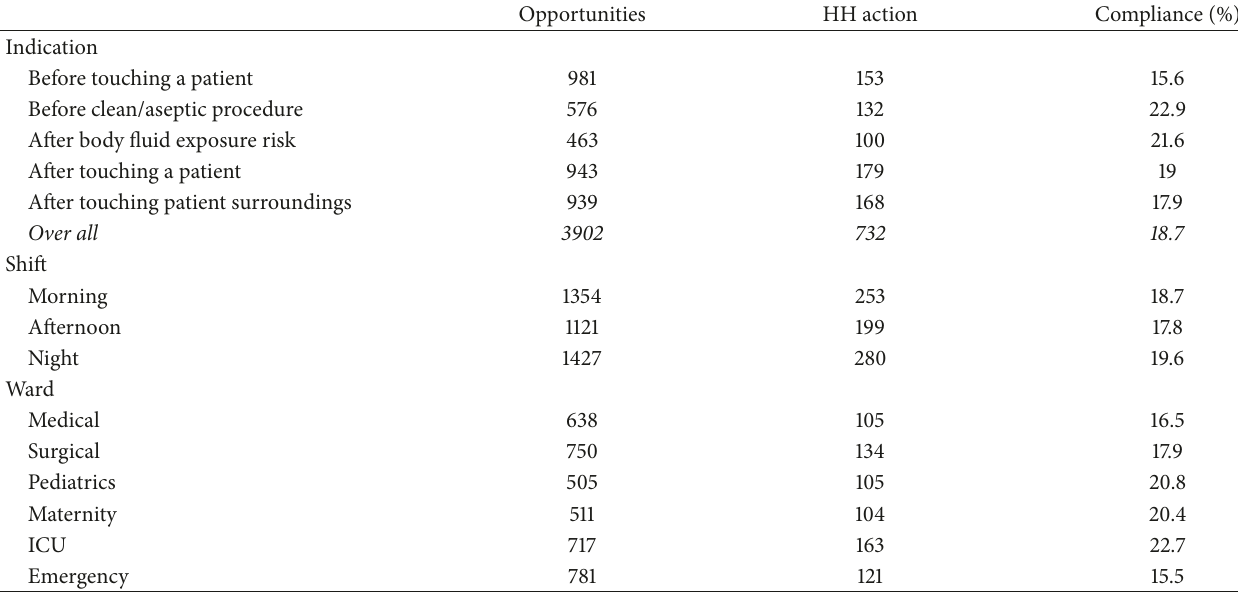
Table 2: Observational hand hygiene practice of Nurses in Hiwot Fana Specialized University Hospital [HFSUH], Harari, Eastern Ethiopia, 2017.